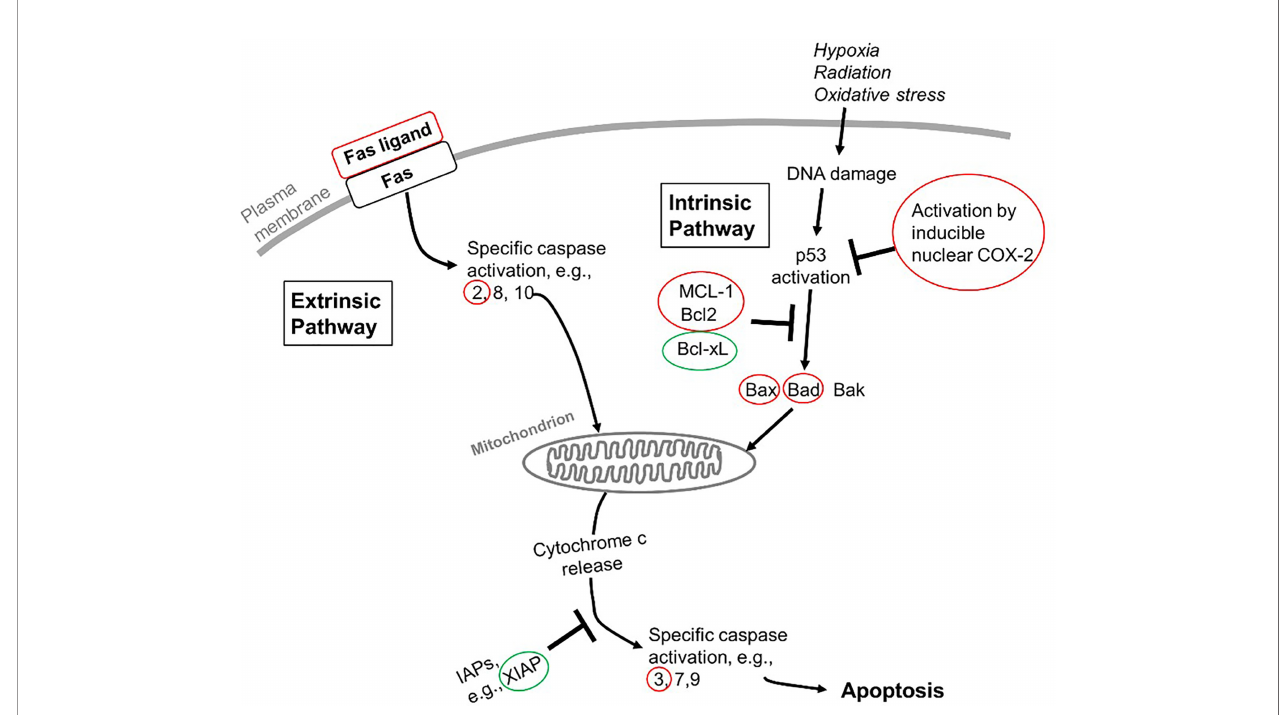
FIGURE 4 | Schematic overview of extrinsic and intrinsic apoptosis pathways in the cell and points at which thyroid hormone in these pathways is anti-apoptotic. The pathways converge at the mitochondrion and cause its permeabilization, with release of cytochrome c and consequent apoptosis. Genes or proteins circled in red or green identify loci of differential actions of thyroid hormone on these multiple factors in apoptosis that are discussed in the current work. Red and green colors identify downregulation and upregulation of factors respectively. The Fas receptor by its interaction with Fas ligand activates the extrinsic pathway. An intrinsic pathway activator is DNA damage from different factors such as radiation or chemotherapy. Bcl-2, B cell lymphoma-2; Bcl-xL, Bcl-2-related gene, long form; Bad, Bcl-2/Bcl-xL-associated death domain protein; Bak, Bcl-2 homologus antagonist killer protein; Bax, Bcl-2-associated X protein; IAPs, inhibitors of apoptosis; MCL-1, myeloid leukemia cell-1; XIAP, X-linked inhibitor of apoptosis. Reprinted from Lin HY, Glinsky GV, Mousa SA, Davis PJ. Thyroid hormone and anti-apoptosis in tumor cells. Oncotarget. 2015;6(17):14735-14743 under the terms of the Creative Commons Attribution